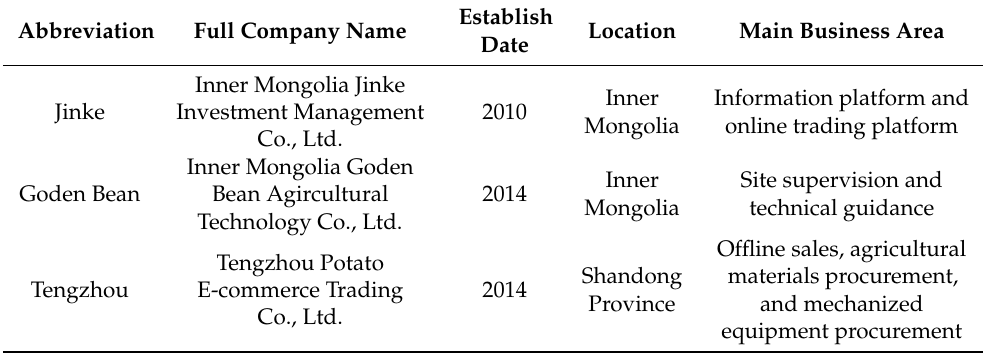
Table 1. Composition of the Tudouec